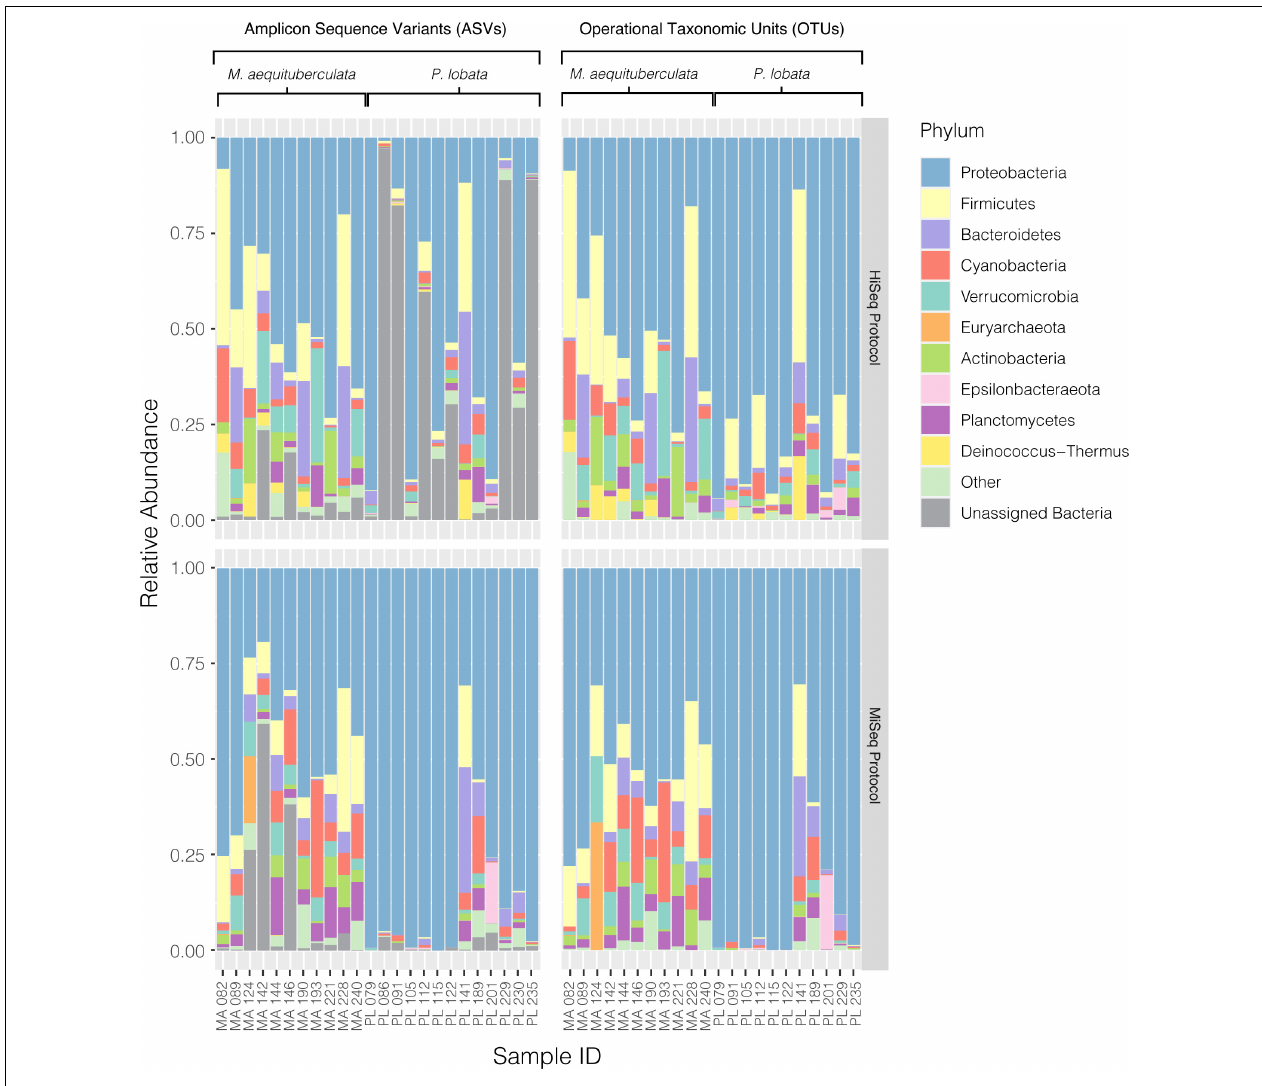
FIGURE 3 | Relative abundances of the top ten most abundant bacterial phyla present in each coral sample from both M. aequituberculata and P. lobata prepared and sequenced using the HiSeq protocol (top) and the MiSeq protocol (bottom), using both the ASV (left) and OTU (right) datasets. “Other” groups phyla that are not in the top ten most abundant, and “Unassigned Bacteria” refers to unassigned bacterial